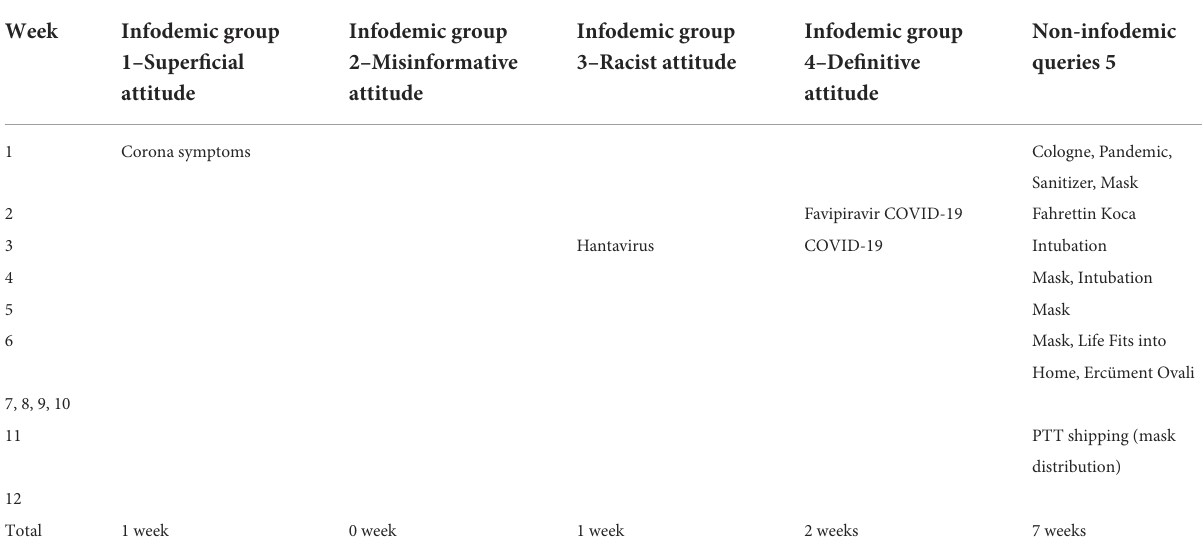
TABLE 1 Distribution of infodemic concepts related to